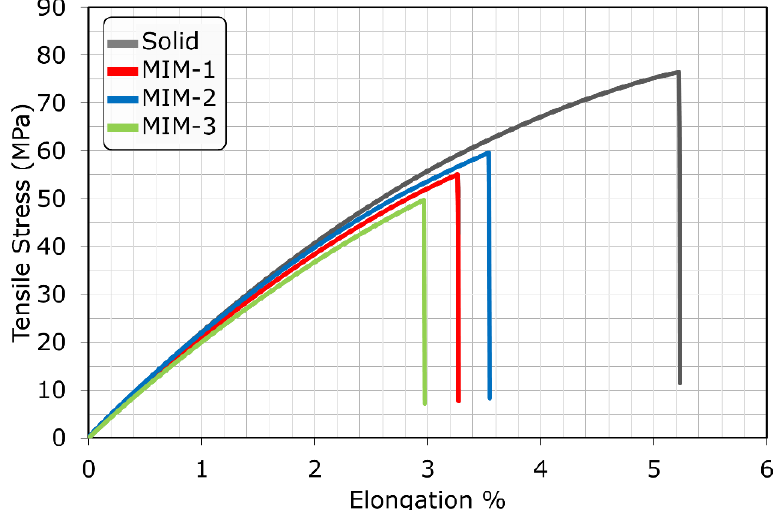
Figure 8. Tensile stress vs. strain (elongation %) curves for the four tensile test bar samples.